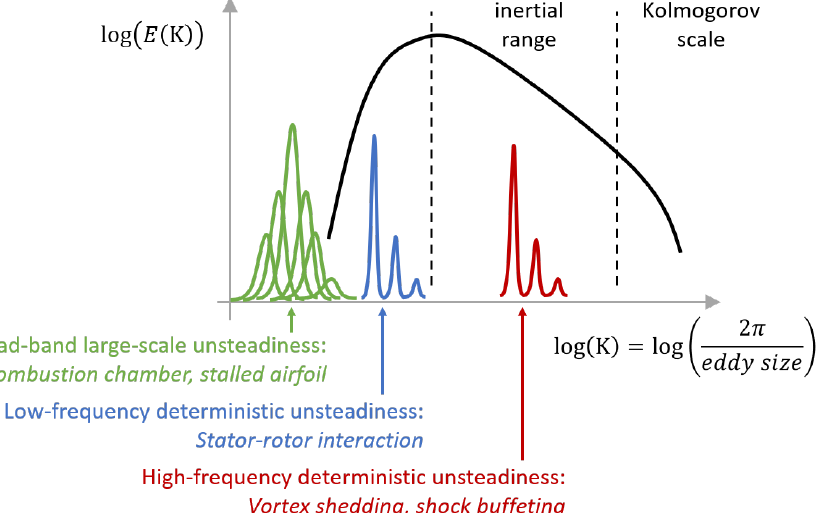
Figure 3. Energy spectrum for turbomachinery showing the different scales at which deterministic frequencies can contaminate the canonical